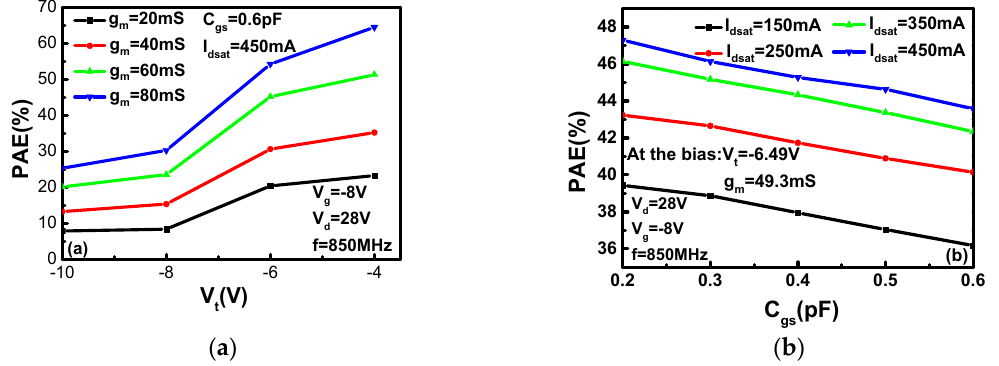
Figure 4. The effect of device parameters on PAE: ( a ) PAE- V t and g m , ( b ) PAE - C gs and I dsat.